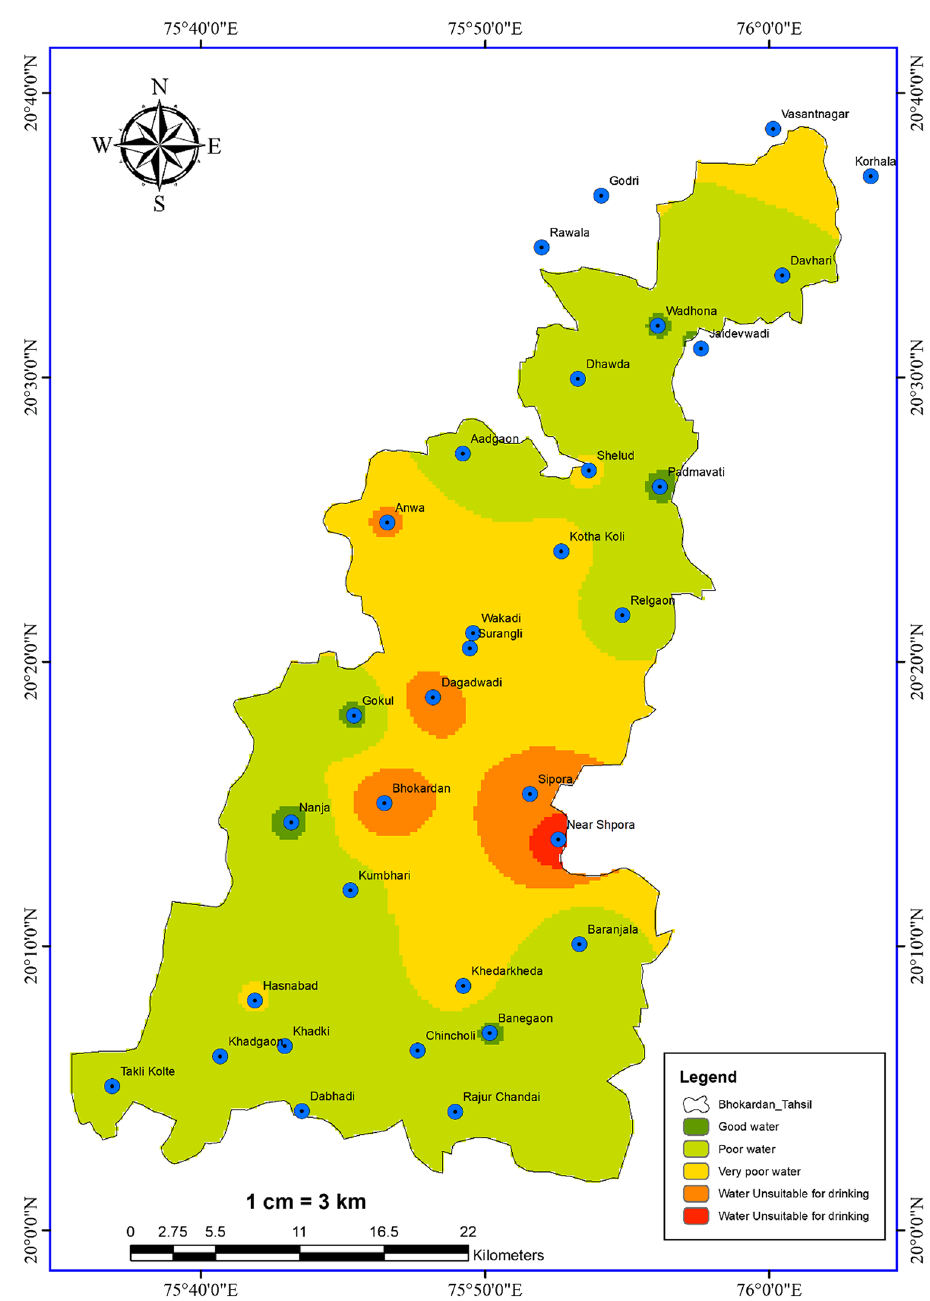
Fig. 4 Showing spatial distribu- tion of GWQI during pre-mon- soon